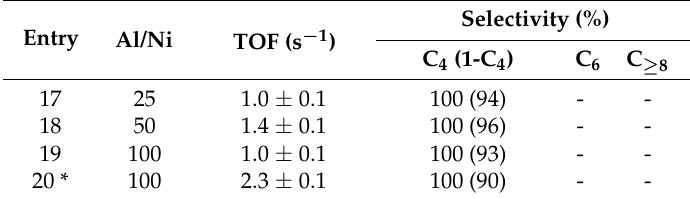
Entry Al/Ni TOF (s − 1